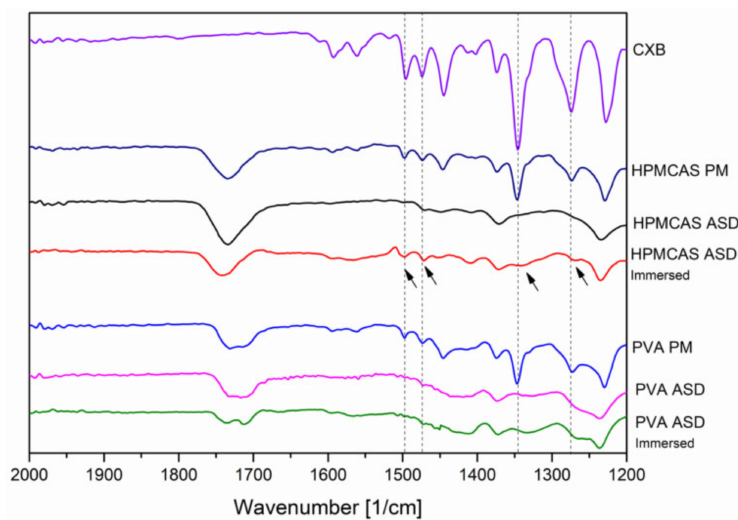
Figure 6. Fourier-transformed infrared spectra of the 20% drug load ASD after preparation and after immersion with bu ff er.